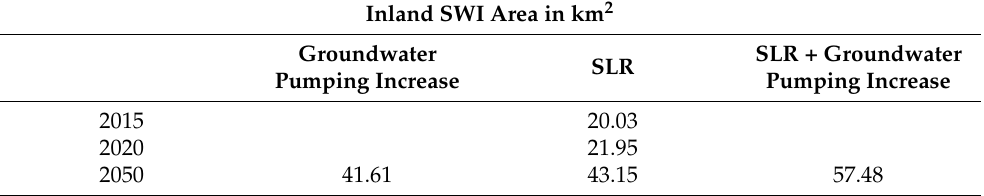
Figure 7. Potential future SWI area in 2050 considering SLR and groundwater abstraction rate increase. Table 2. SWI area in km 2